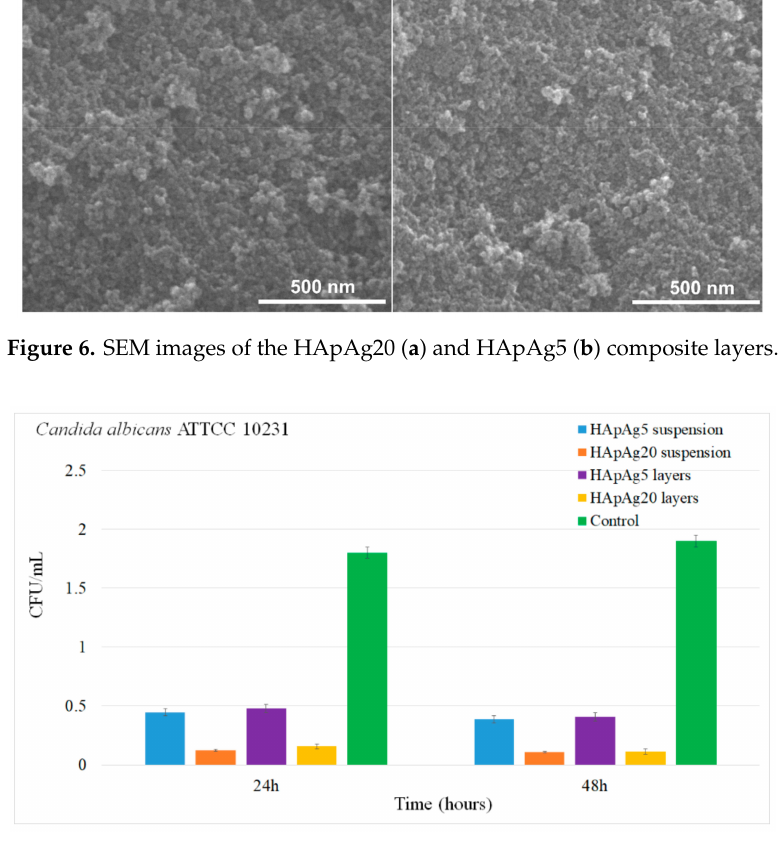
Figure 7. Antifungal activity of HApAg5 and HApAg20 nanoparticles suspension and composite layers against fungal strain C. albicans ATCC